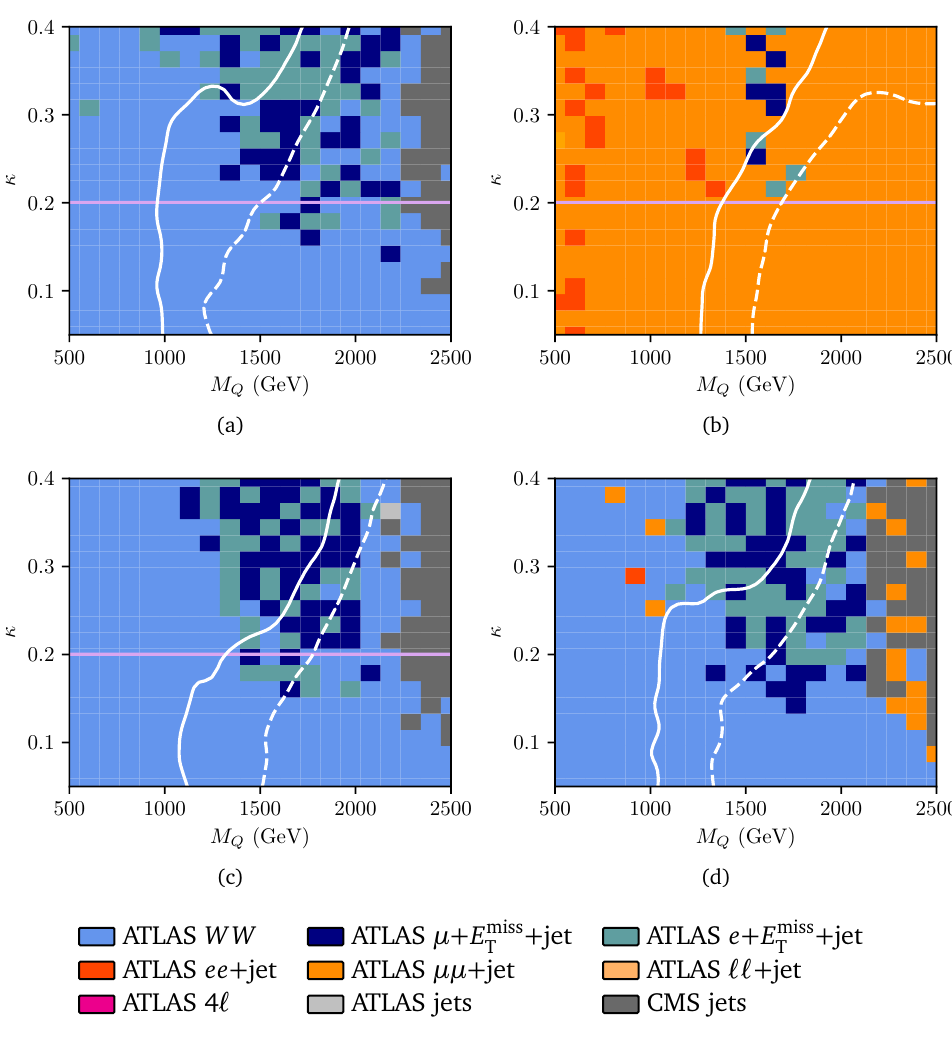
Figure 9: Dominant LHC analysis pools contributing to VLQ limit-setting in the κ vs VLQ mass plane, where κ is the coupling to second-generation SM quarks. All VLQ ( B , T , X , Y ) masses are set to be degenerate. The disfavoured regions are located above and to the left of the dashed (68% CL) and solid (95% CL) white contours respectively. The lower bounds in κ from non-LHC flavour physics are indicated with the pink horizontal contour. The VLQ branching fractions to W : Z : H are (a) 0:0:1 (b) 0:1:0 (c) 1:0:0 and (d) 1 : 1 : 1 2 4 4